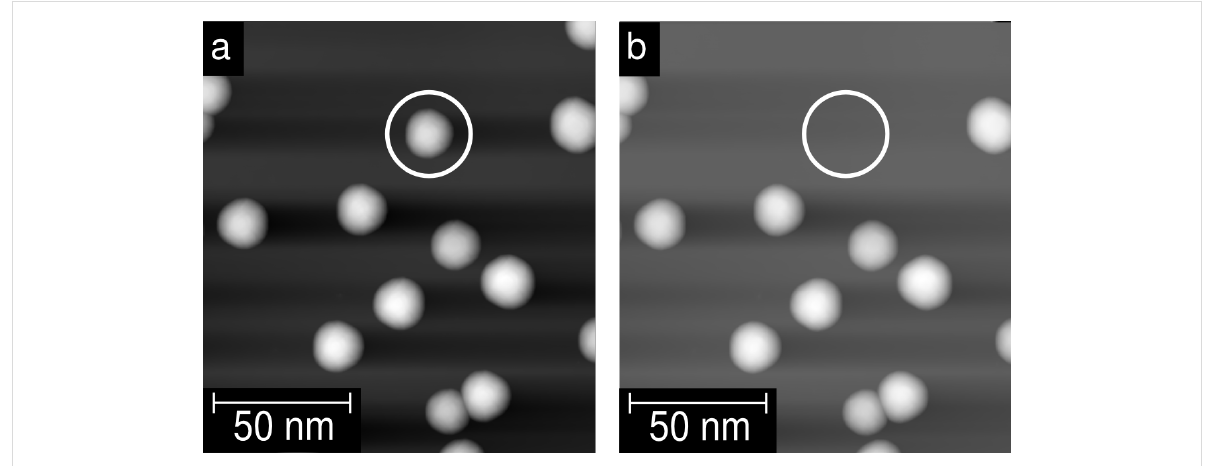
Figure 7: STM images of the HOPG surface (a) before, and (b) after the picking up of an individual cluster. The area of interest is marked with a white circle.